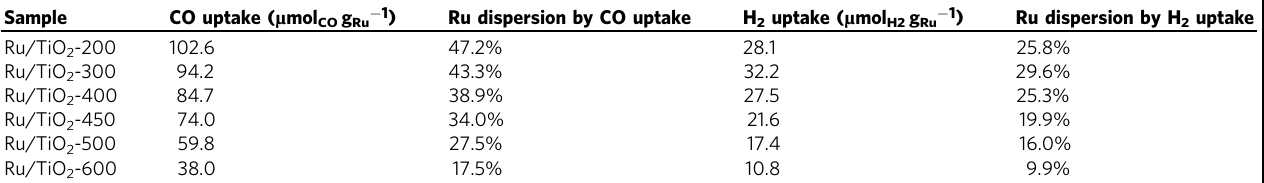
Table 1 H 2 and CO chemisorption results for different Ru/TiO 2 − x samples. Sample